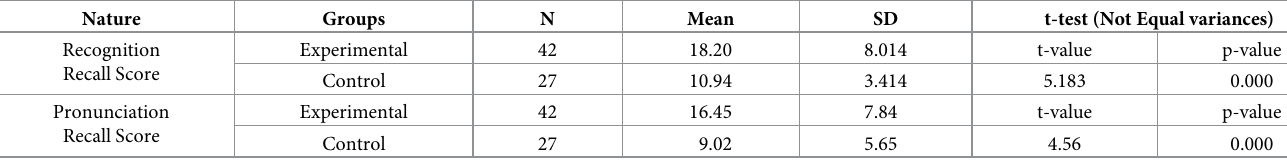
Table 6. Statistics of alphabet letter recall scores of experimental and the CG. Nature